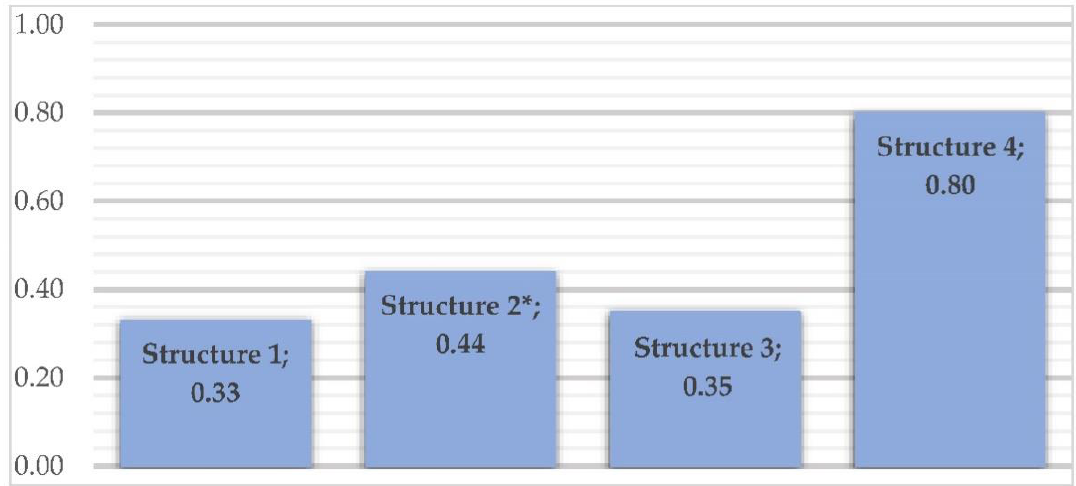
Figure 7. The final result of each structure. * Structure 2 did not meet the investor’s conditions.